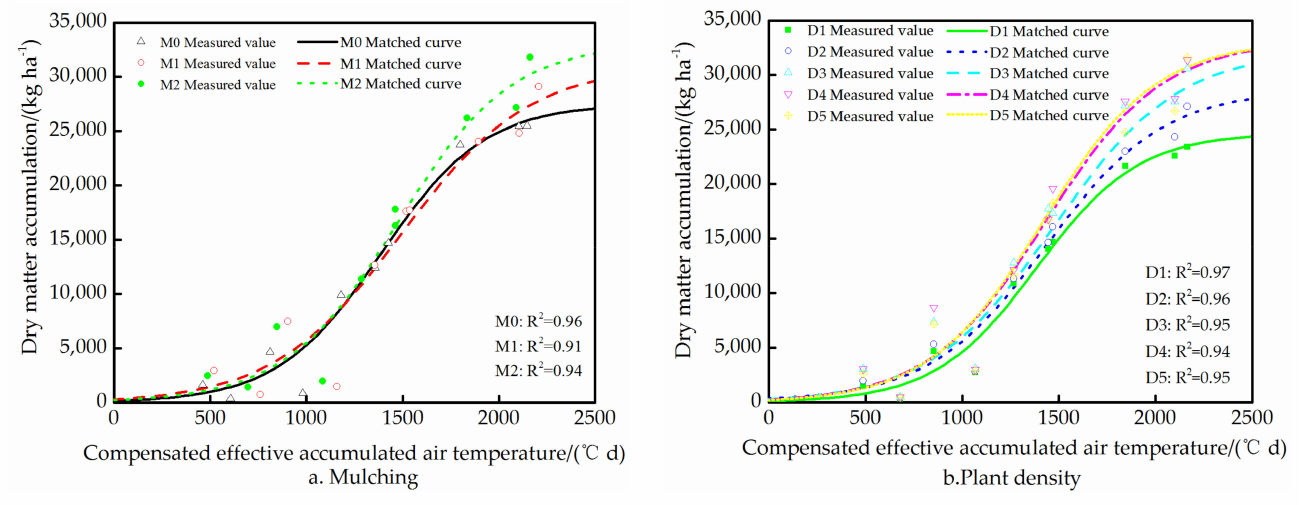
Figure 2. The measured value of DMA (average of each treatment in 2016 and 2017) and the fitted growth curve of DMA under film mulching ( a ) and PD ( b